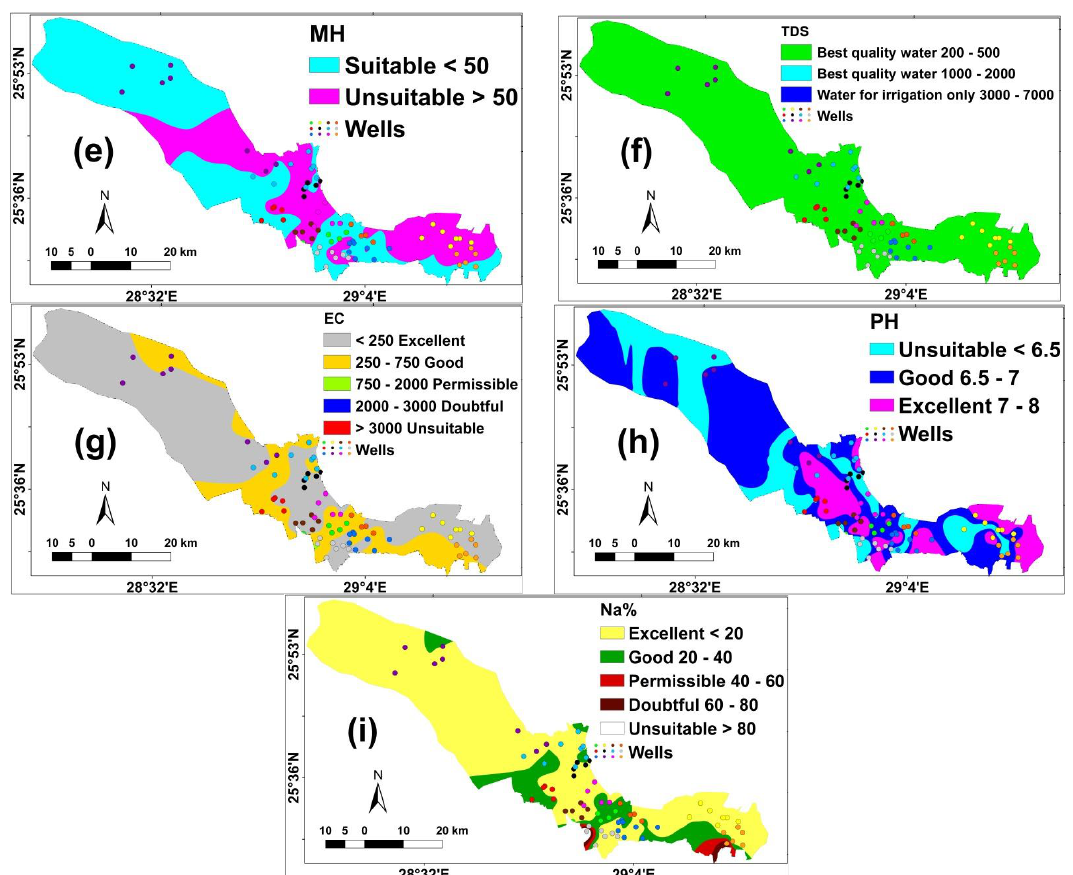
Figure 10. Spatial distribution of groundwater suitability for irrigation. ( a ); SAR, ( b ); RSC, ( c ); TH, ( d ); KR, ( e ); MH, ( f ); TDS, ( g ); EC, ( h ); pH, and ( i ); Na%. Table 6. The rating scores and relative weights of the factors and sub-criteria used for irrigation assessment.